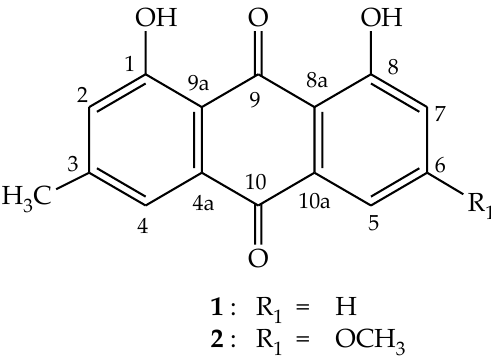
Figure 2. Chemical structures of bioactive constituents identified in EtOAc extract of Rumex crispus L. root by single-crystal X-ray.